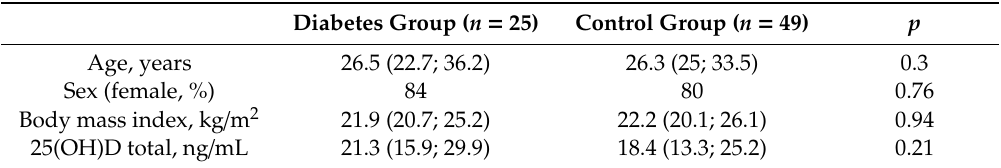
Table 1. General characteristics of the patients at the baseline visit. For a detailed description of the data format, please refer to Section